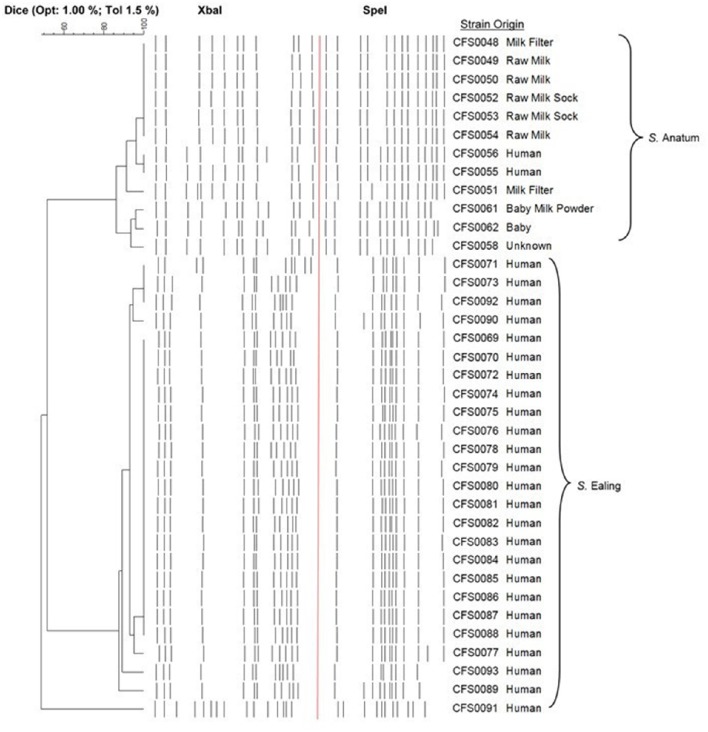
Dendrogram of combined pulsotype profiles following macrorestriction enzyme digestion with Xba1 and Spe1, of genomic DNA from S. Anatum and S. Ealing isolates.